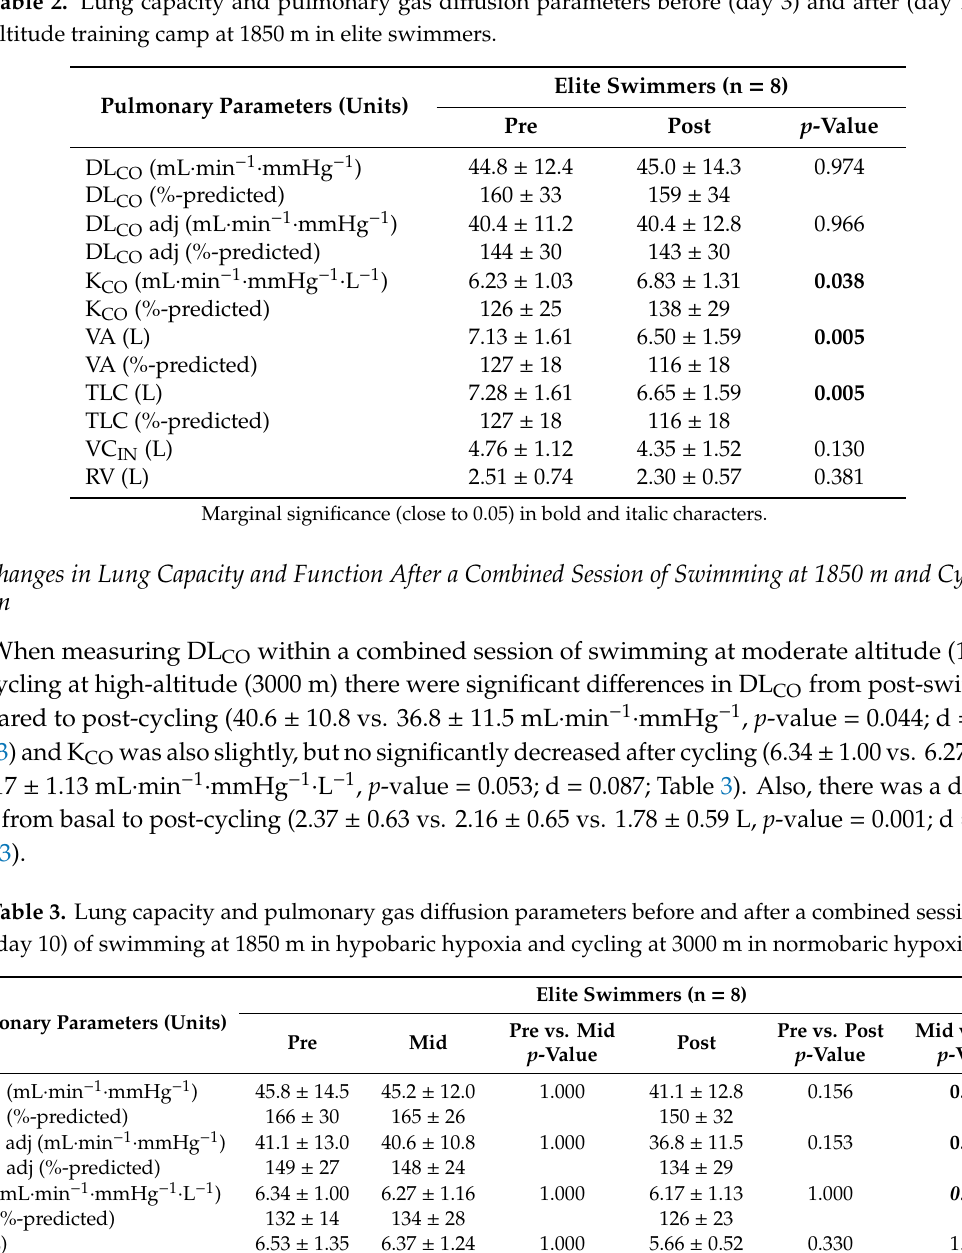
Pulmonary Parameters